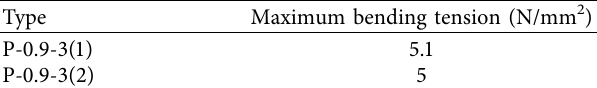
Table 7: The bending test results for two fire-resistance polyure- thane foam